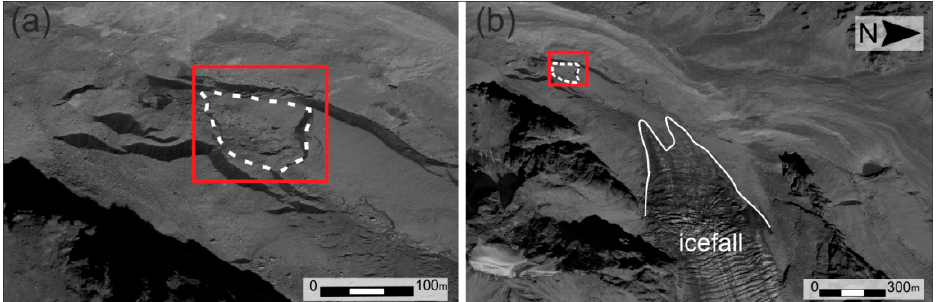
Figure 7. A depression formed at the Aksay Glacier terminus (Worldview-3, 2014). ( a ) Front part of the Aksay Glacier with development of ground surface depressions; ( b ) overview of the Aksay Glacier terminus (white line).